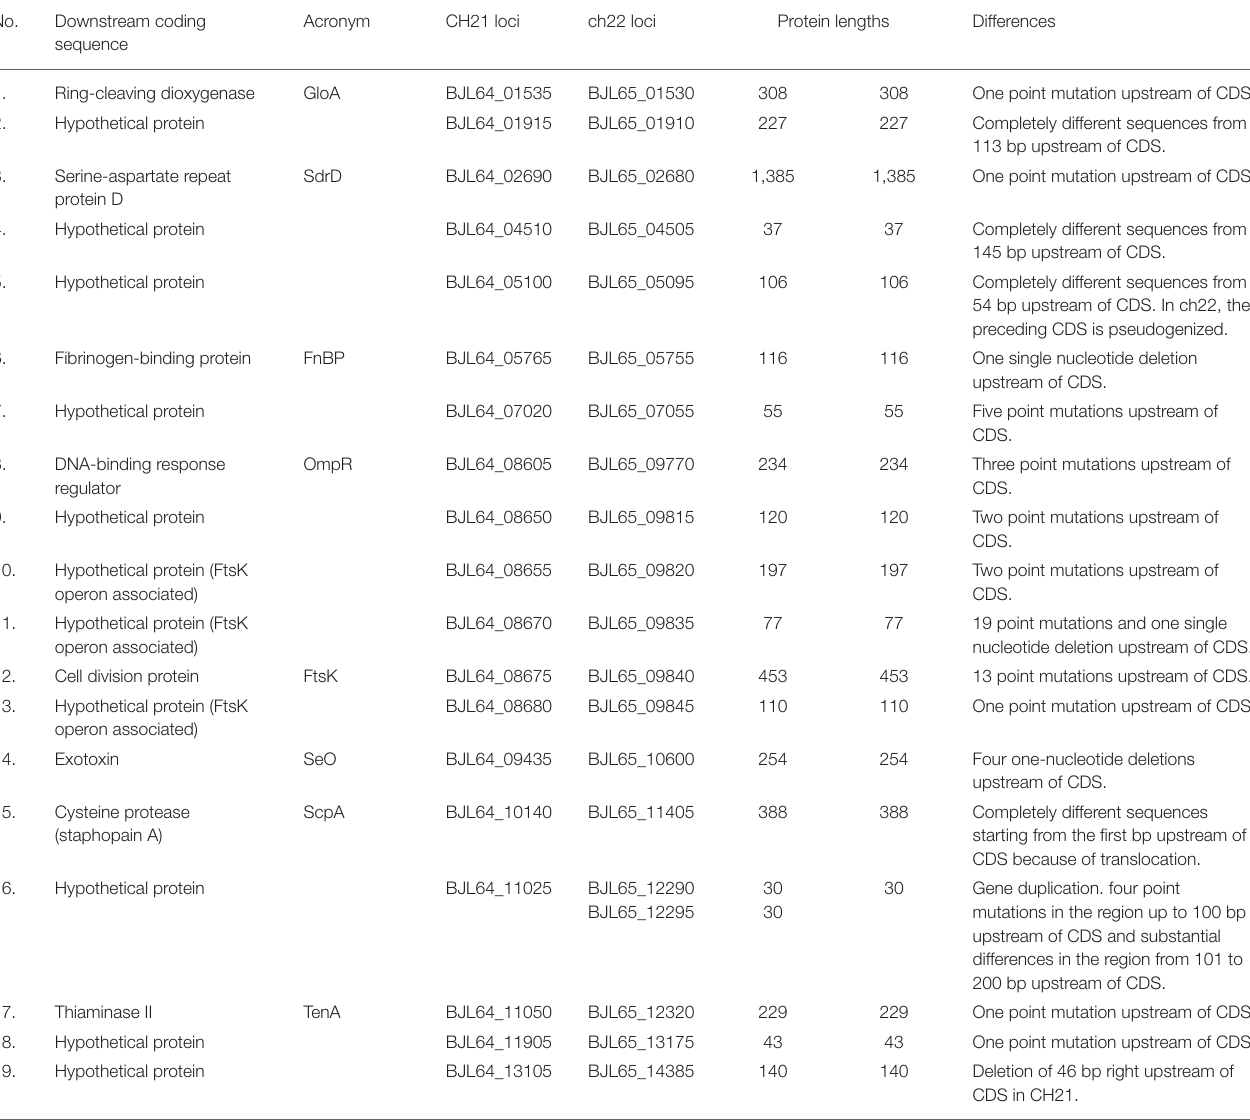
TABLE 4 | Identified differences in putative promoter regions between the VIR CH21 and NVIR ch22 strains.